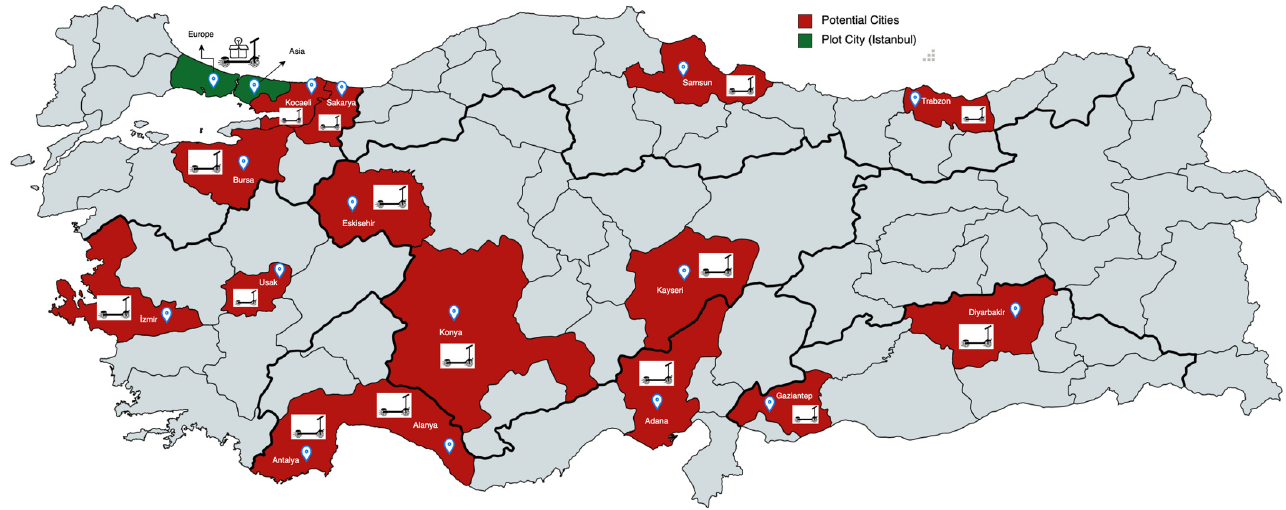
Figure 1. Plot zones selected for packages delivered with the e-scooter application in Turkey.